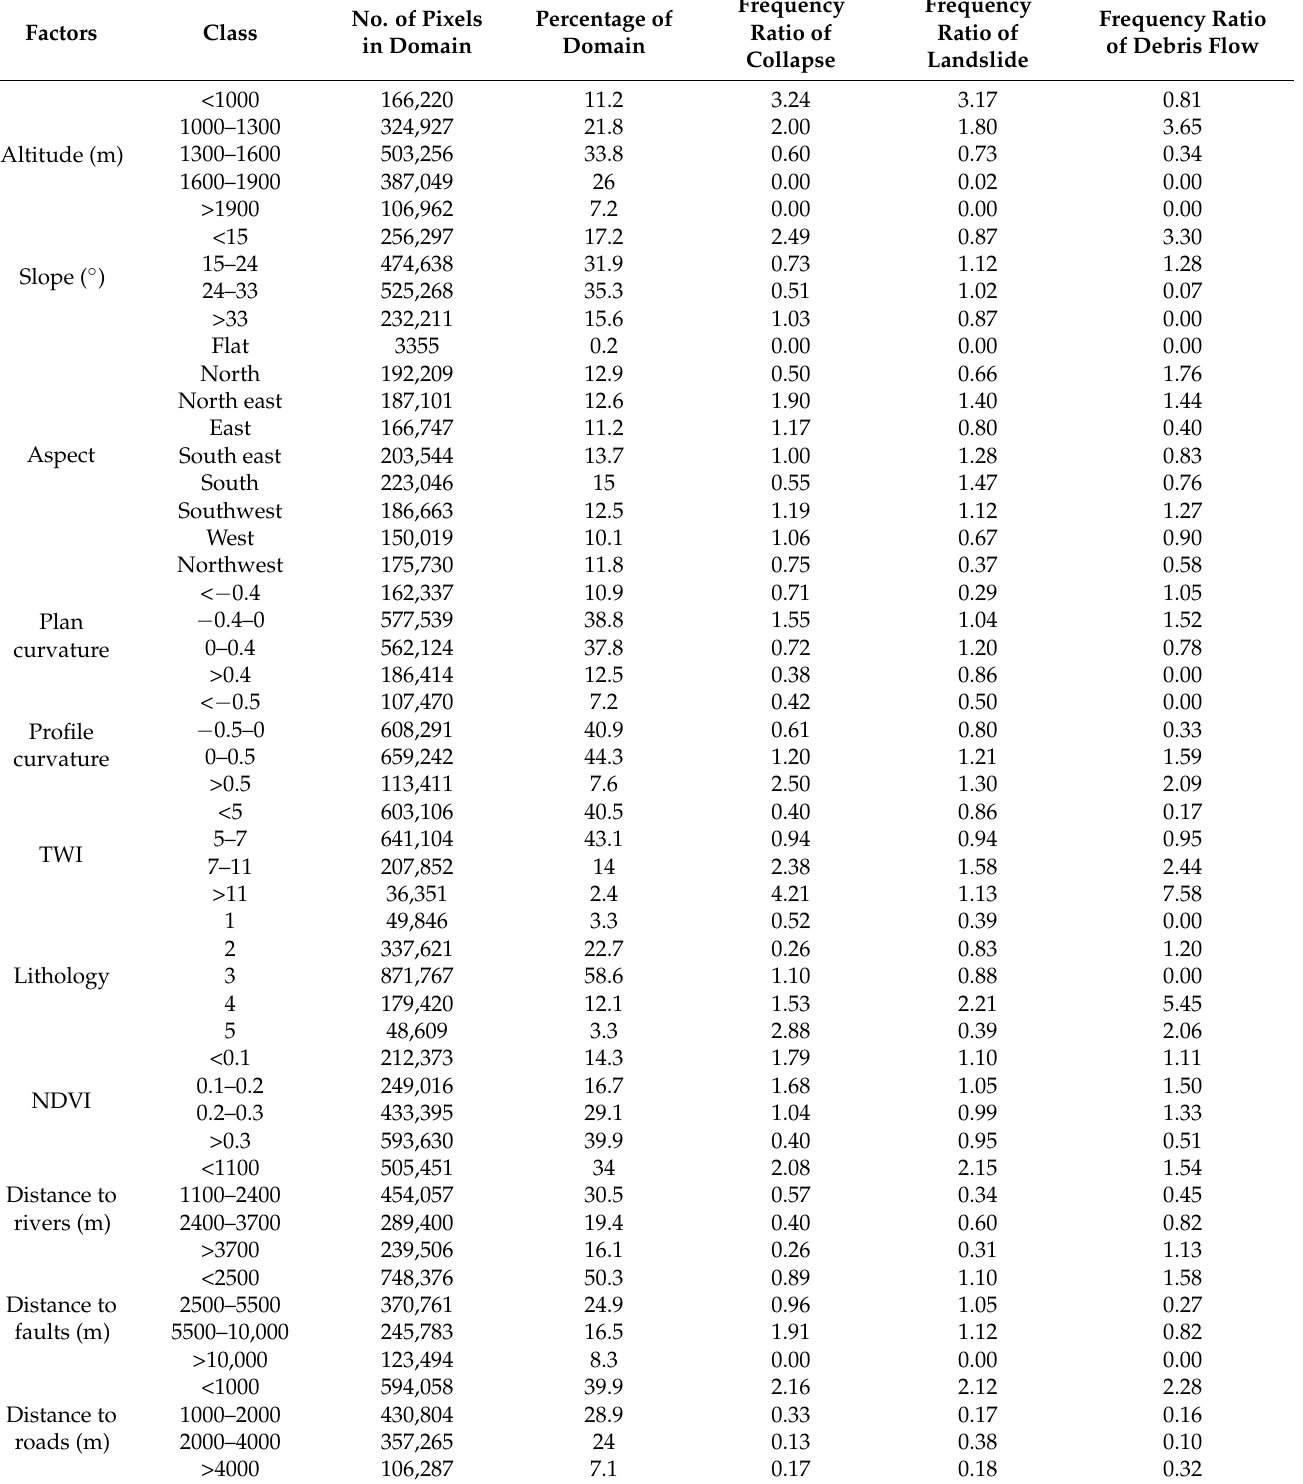
Table 9. The frequency ratio of three geological